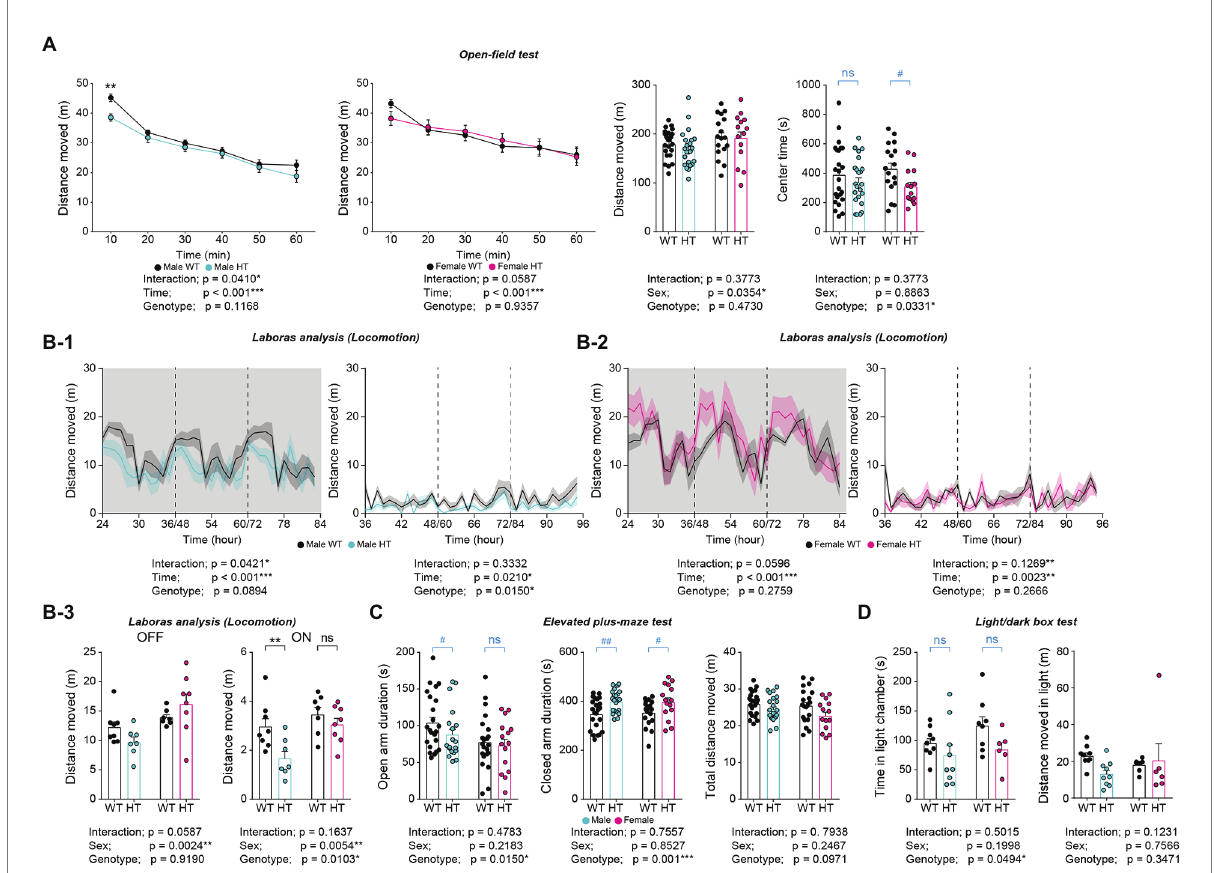
FIGURE 6 Differential increases in anxiety-like behaviors in adult male and female Chd8 +/S62X mice. (A) Male and female Chd8 +/S62X mice (2–3 months) show normal levels of locomotor activity in the open-field test, compared with WT mice, as shown by the distance moved and supported by